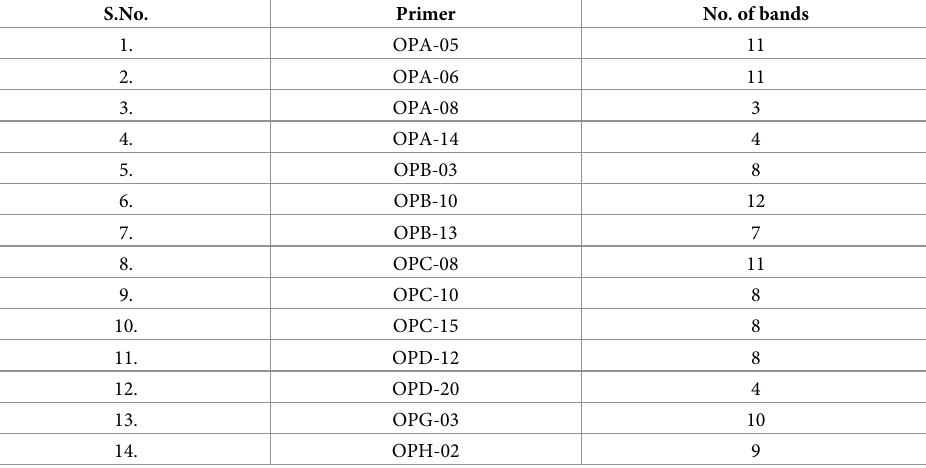
Table 1. Number of amplification products generated with the use of RAPD primers for the analysis of clonal fidelity of T . indica microshoots. S.No.